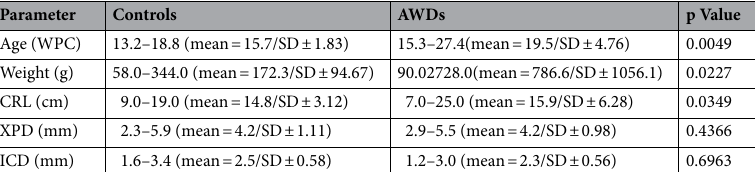
Table 1. Statistical analysis of fetal and abdominal wall biometric parameters. AWDs abdominal wall defects, CRL crown-rump length, XPD xiphopubic distance, ICD iliac crest distance.